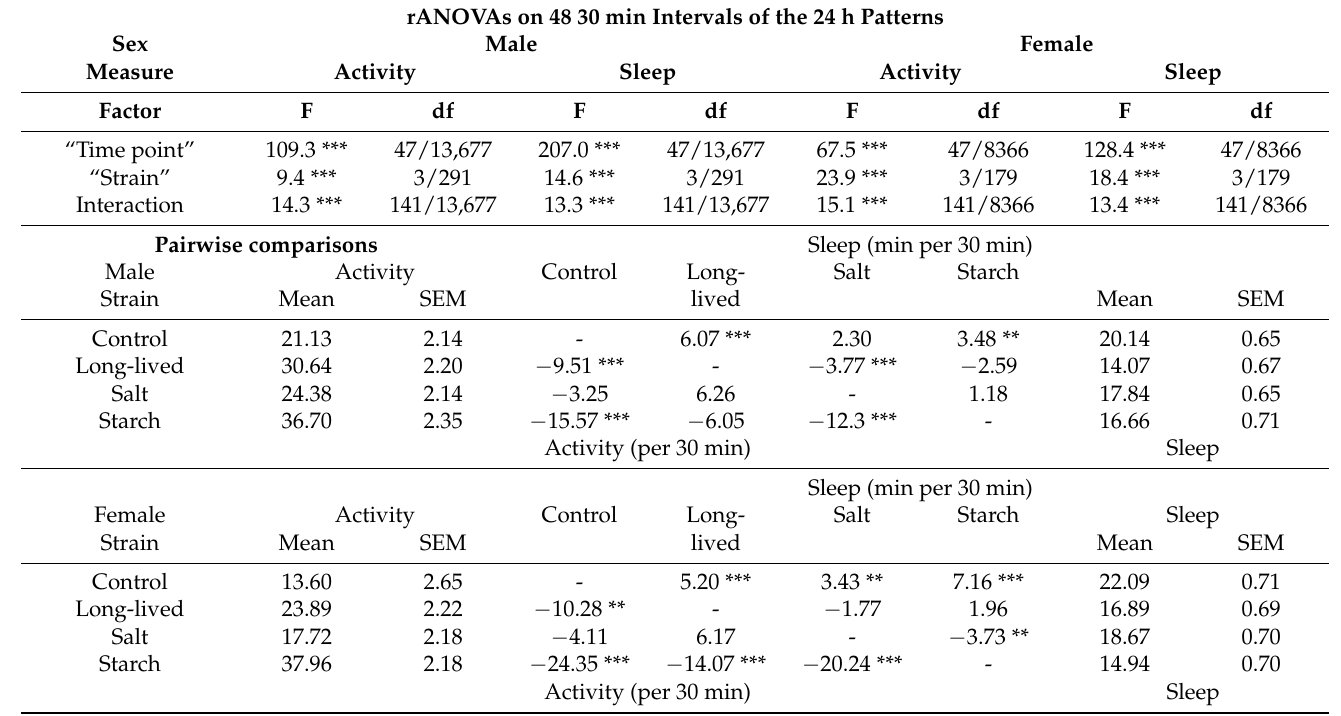
Table 1. Two-way rANOVAs of locomotor activity and sleep.